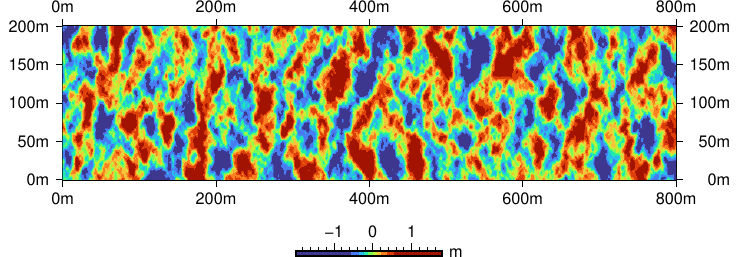
Figure 10. Simulated two-dimensional WSSE using the Pierson–Moskowitz spectrum.